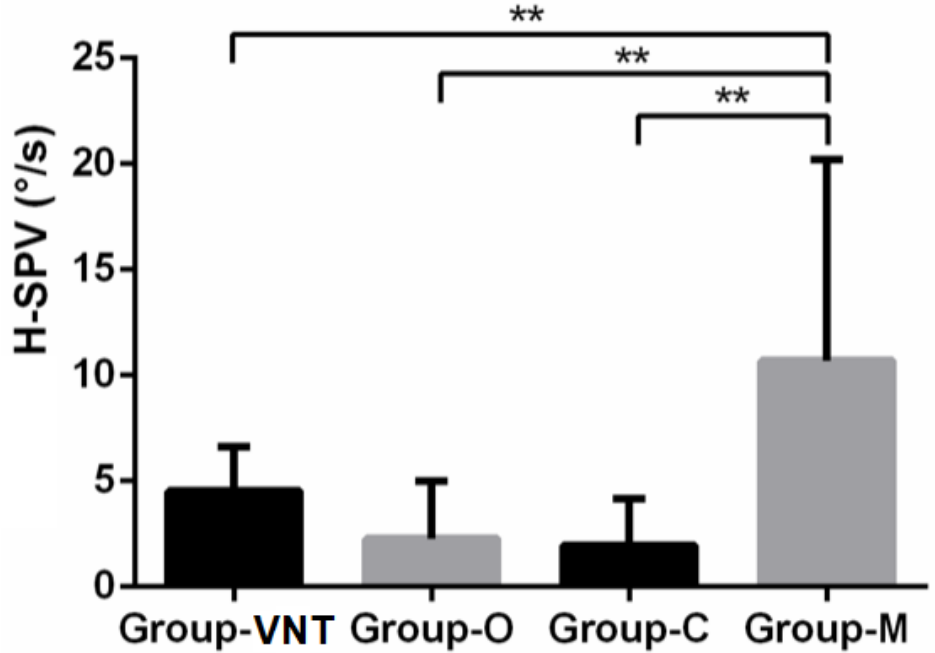
Figure 2. H-SPV bar chart with standard error by pathological groups. (**: p < 0.01). The comparison of caloric hypofunction and L-VHIT asymmetry between Group-C and Group-M did not reveal statistical difference ( p = 0.97 and p = 0.35, respectively). In Group-VNT, 83% of patients had a positive SVIN, meanwhile all the other tests were negative. These patients represent 11% of the all population analyzed (Groups-N, O, C, M) (i.e., SVIN is the only positive routine test for approximately 10% of patients with vertigo). Conversely, SVIN is negative in 13% of patients with positive CVT and OVT. 3.2. SVIN Horizontal Component The horizontal component SVIN-SPV was analyzed and compared to results in each other vestibular test. SVIN positivity was significantly different in face of positive/negative CaT ( p < 0.05), positive/negative oVEMP ( p < 0.05) but not in front of modalities of L-VHIT ( p = 0.13) and cVEMP ( p = 0.29) (Table 3). However, there was a significant difference for H-SVIN-SPV values regarding L-VHIT results ( p < 0.001). Figure 3 shows that there was no difference in H-SPV with positivity of cVEMP ( p = 0.581), but positive groups of oVEMP, CaT and L-VHIT were significantly different from their respective negative groups ( p = 0.006, 0.002, <0.001 respectively) (Table 3). The introduction of these 3 variables in the logistic regression models showed an odd ratio for oVEMP: 2.06 (+/ − 0.57, p = 0.024), for L-VHIT: 3.13 (+/ − 1.5, p = 0.03) and for CaT: 4.34 (+/ − 4.5, p = 0.1).